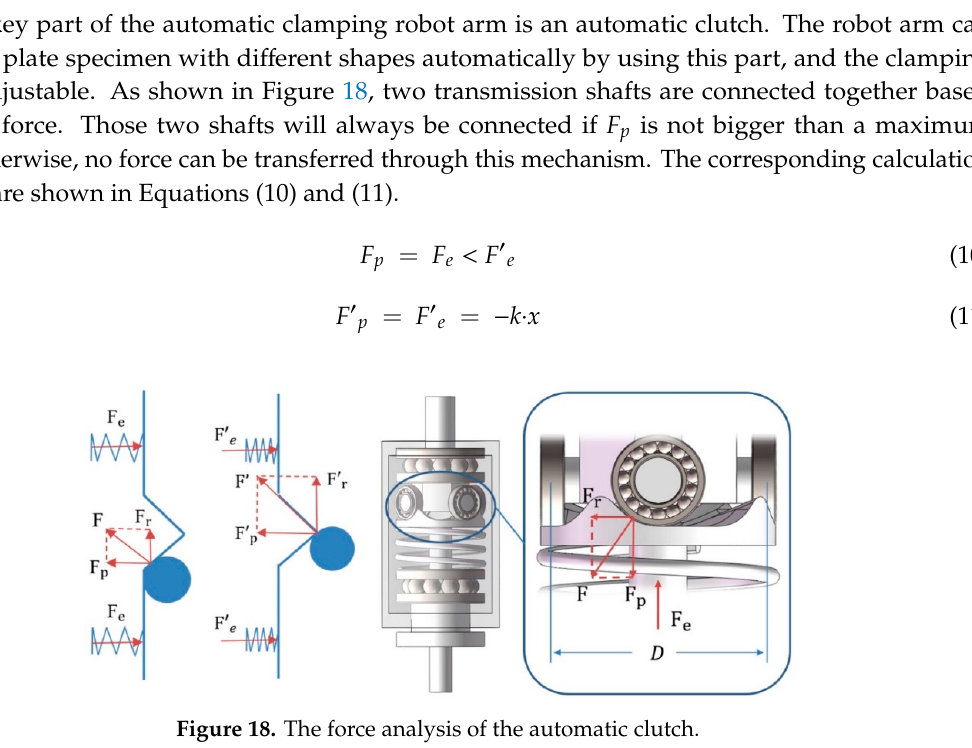
Figure 17. The 3-D model of the automatic clamping robot arms.